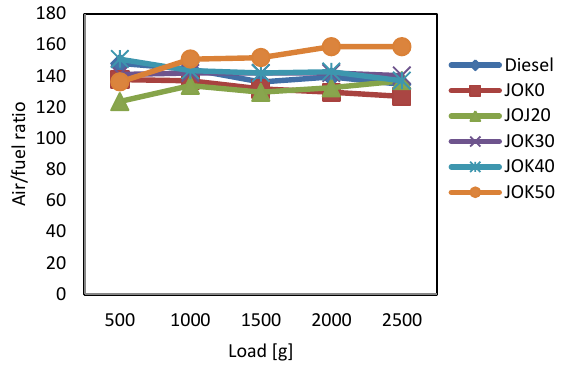
Fig. 4. Variation of AFR for JOK blends with increase in load The illustration of BSEC variations for tested fuels and blends as a function of load is presented in Fig. 5. The trends in BSEC at minimum and maximum loads are dis- cussed as follows: JOK0 fuel sample decreased from 6.7% to 2.7%; JOK20 blends decreases from 37% to 31.2%; JOK30 fuel decreased from 28.7% to 13.1%; JOK40 sam- ple decreased from 9.9% to 9.8%. JOK50 blended fuel sample decreased from 24.4% to 21.4%. A general decrease in BSEC with increase in load was observed for all tested fuel samples under the varying loading condition.